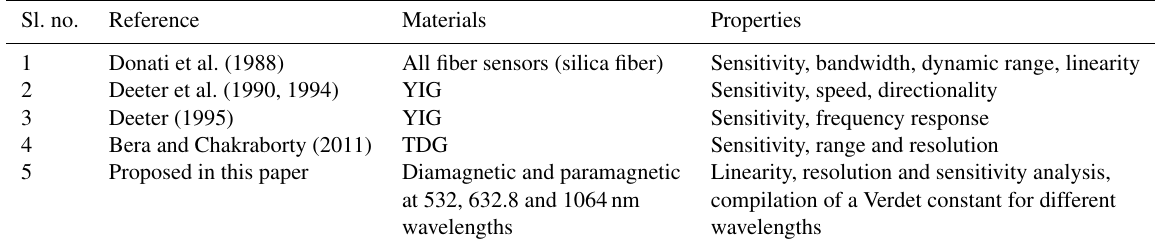
Table 2. Work done by various researchers. Sl.